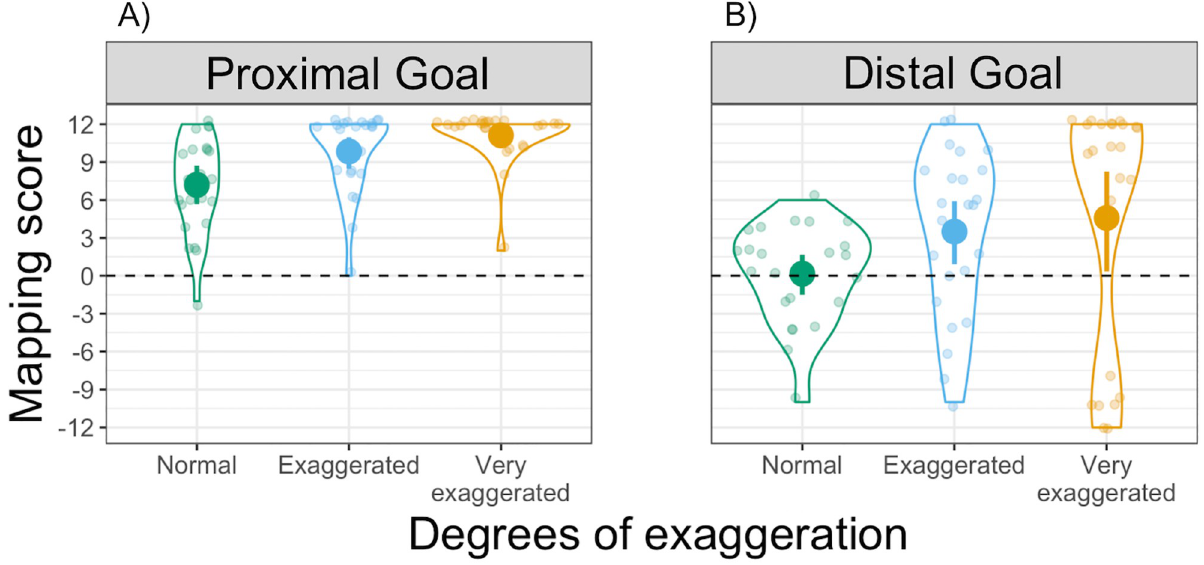
Fig 4. Mapping scores in Experiment 1. Distribution of Mapping scores in the (A) Proximal and (B) Distal goal conditions, for the three degrees of exaggeration. Each dot represents an individual participant, with one Mapping score for each degree of exaggeration. Violin plots represent the overall distribution of Mapping scores for each degree of exaggeration. The dashed horizontal line indicates random mapping